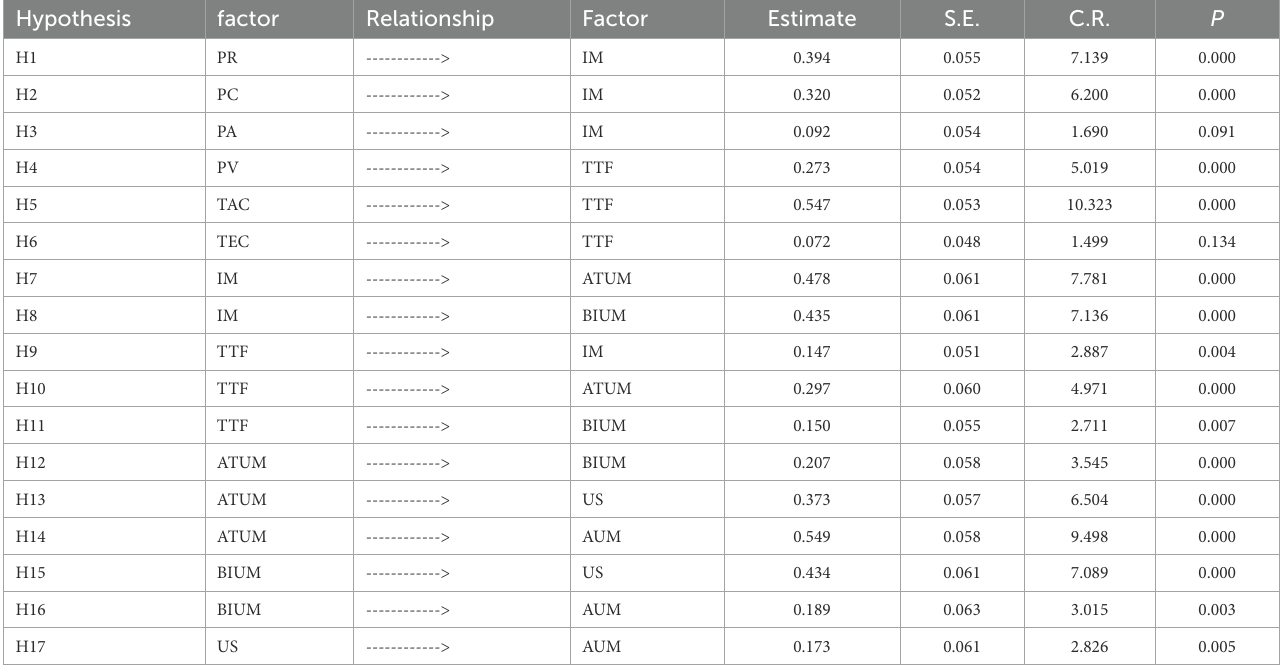
TABLE 5 Structural model for hypothesis testing